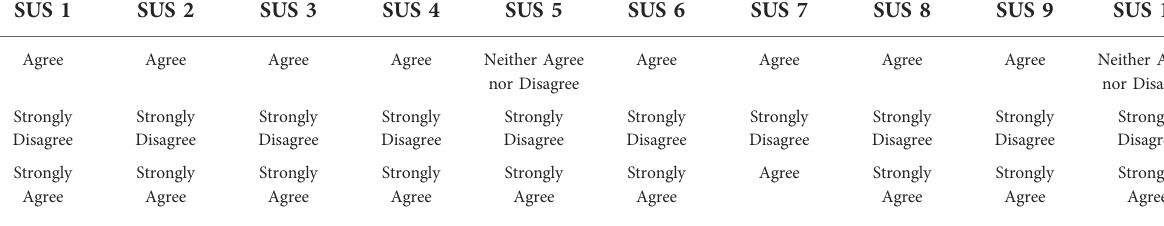
TABLE 2 Exclusion criteria for qualitative